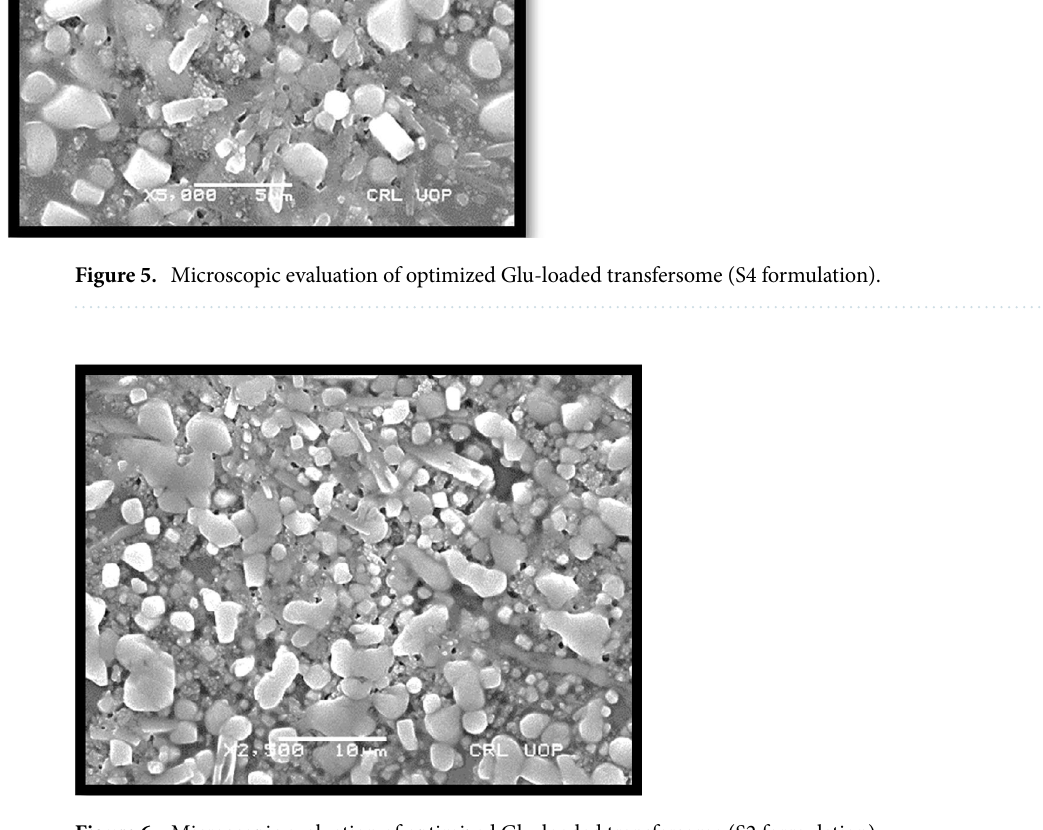
Figure 6. Microscopic evaluation of optimized Glu-loaded transfersome (S2 formulation).